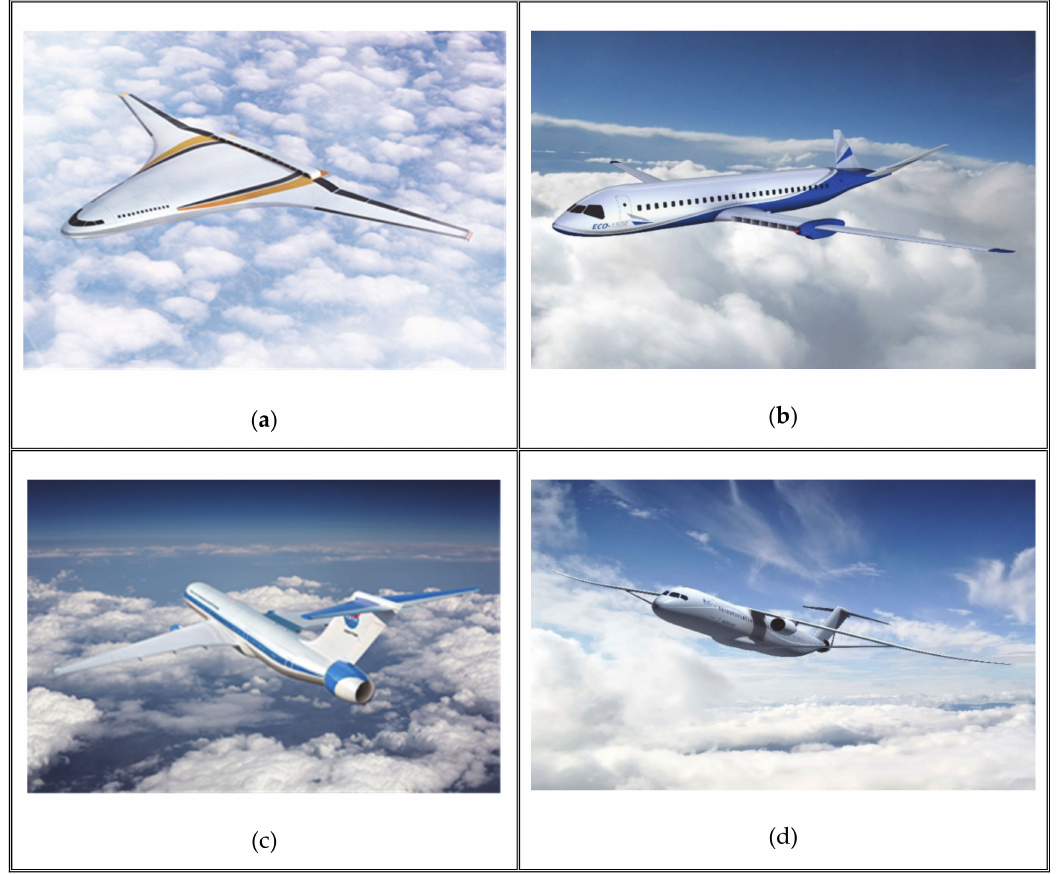
Figure 2. Distributed turboelectric and partially turboelectric configurations from NASA: ( a ) N3-X; ( b ) ECO-150; ( c ) STARC-ABL; ( d ) SUGAR